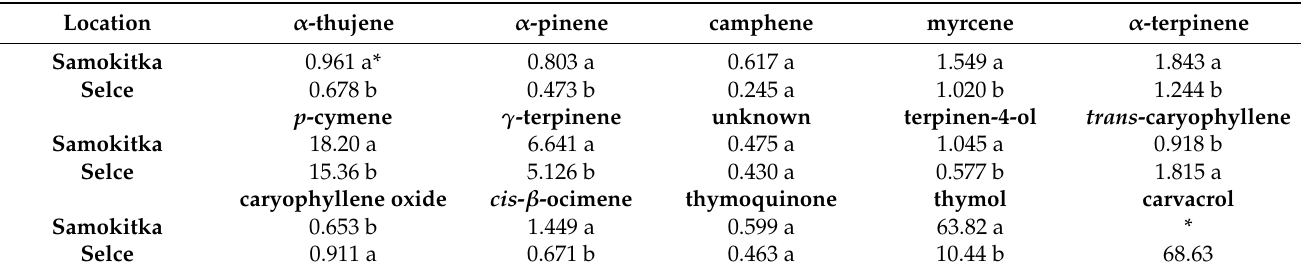
Table 7. Mean concentration (%) of α -thujene, α -pinene, camphene, myrcene, α -terpinene, p -cymene, γ -terpinene, unknown, terpinen-4-ol, trans -caryophyllene, caryophyllene oxide, cis- β -ocimene, thy- moquinone, thymol, and carvacrol of S. pilosa collected at the 2 locations. Location α -thujene α -pinene camphene myrcene α -terpinene Samokitka terpinen-4-ol trans